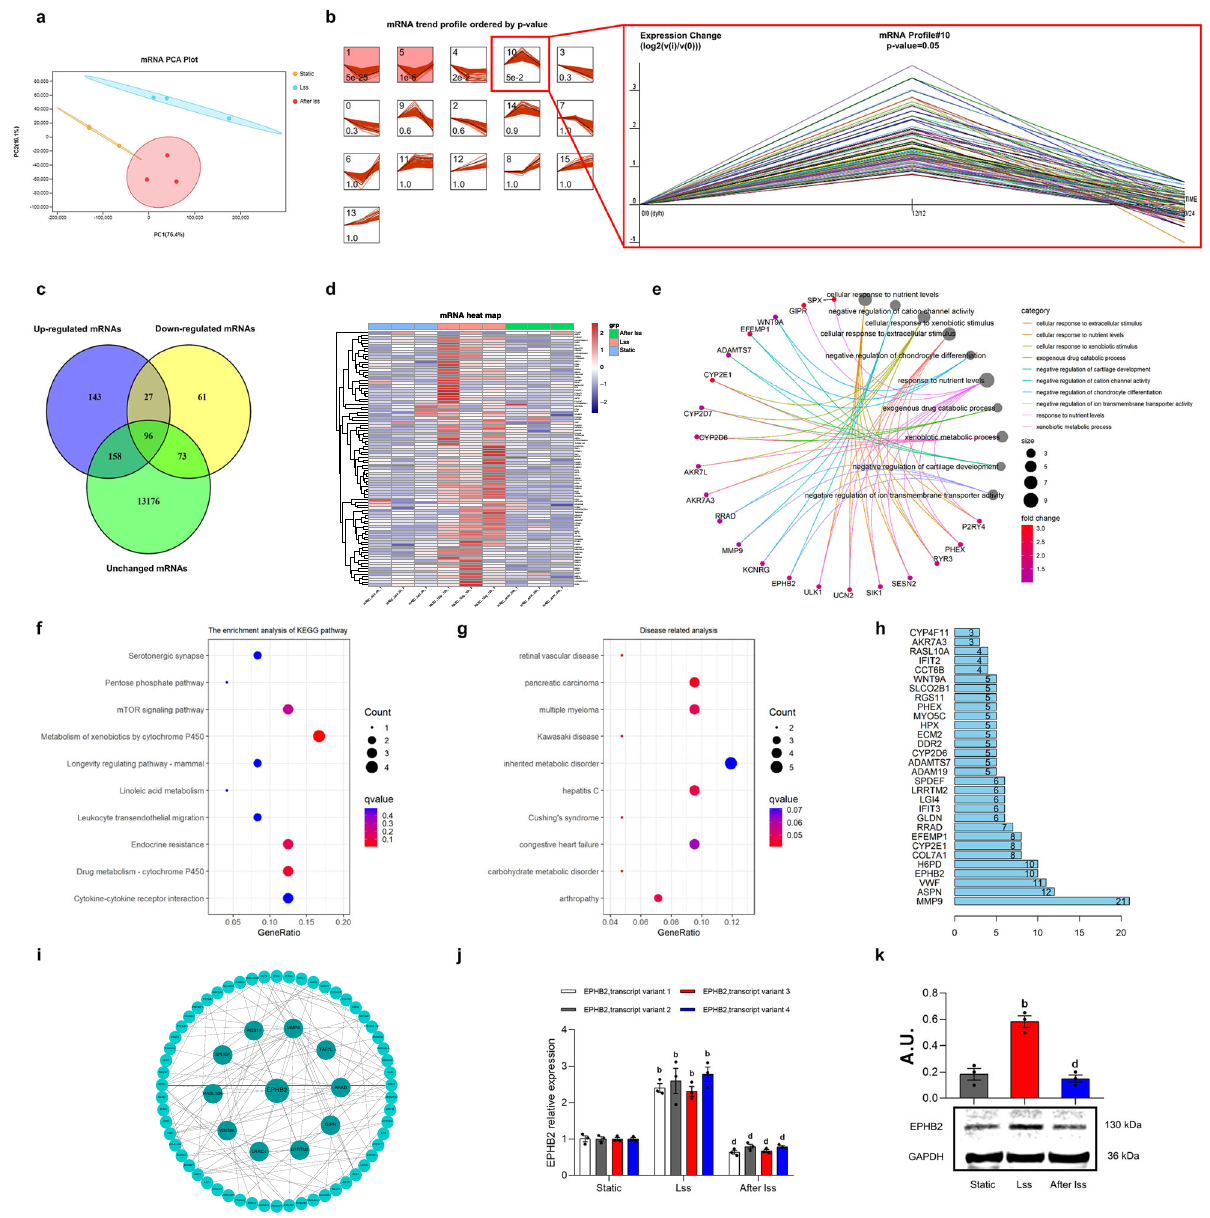
Fig. 2 Whole-transcriptome sequencing analysis revealed that EPHB2 was a key gene in response to LSS. a mRNA PCA analysis of HAECs in three groups. b mRNA trend pro fi les ordered by P value. Expression Change (log2(v(i)/v(0))). c DE mRNA Venn diagram. d DE mRNA heat map. e DE mRNA GO biological process analysis. f DE mRNA KEGG pathway analysis. g DE mRNA disease correlation analysis. h PPI histogram of DE mRNA. i PPI network diagram with EPHB2 as the core. j qRT-PCR shows the expression of EPHB2. k Western Blot shows the expression of EPHB2. Data are presented as mean ± SEM of three independent experiments. a P < 0.05, b P < 0.01 vs. Static group; c P < 0.05, d P < 0.01 vs. LSS group. AU arbitrary